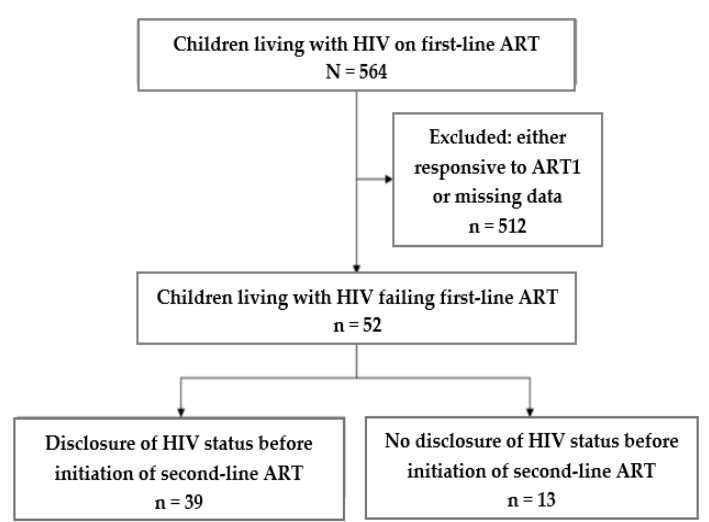
Figure 1. Flow diagram showing the children and adolescents on ART at KLLPH, DRC, between 2004 and 2008 and the group who failed on ART1.